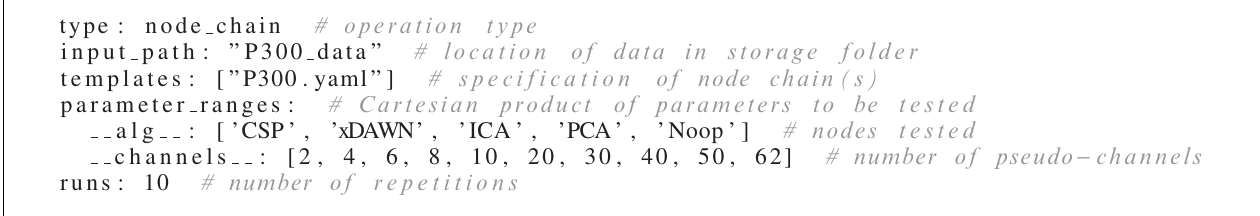
node chain can be parameterized and thus different algorithms and parameters can be tested. To show that for such a